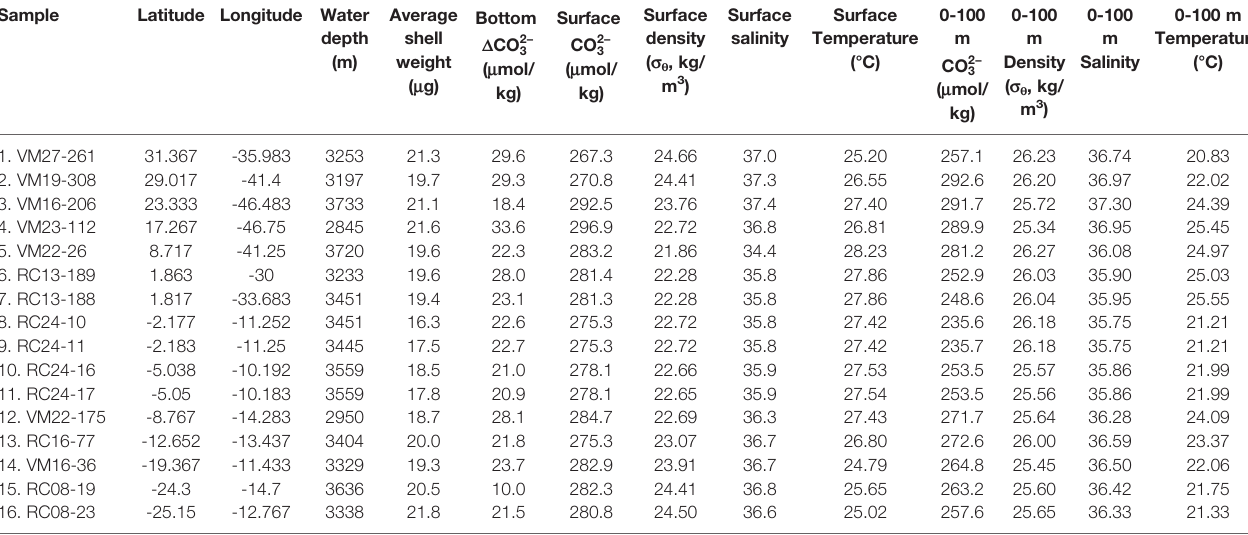
TABLE 1 | Table of cores from which core-top samples were obtained for shell weight analyses.